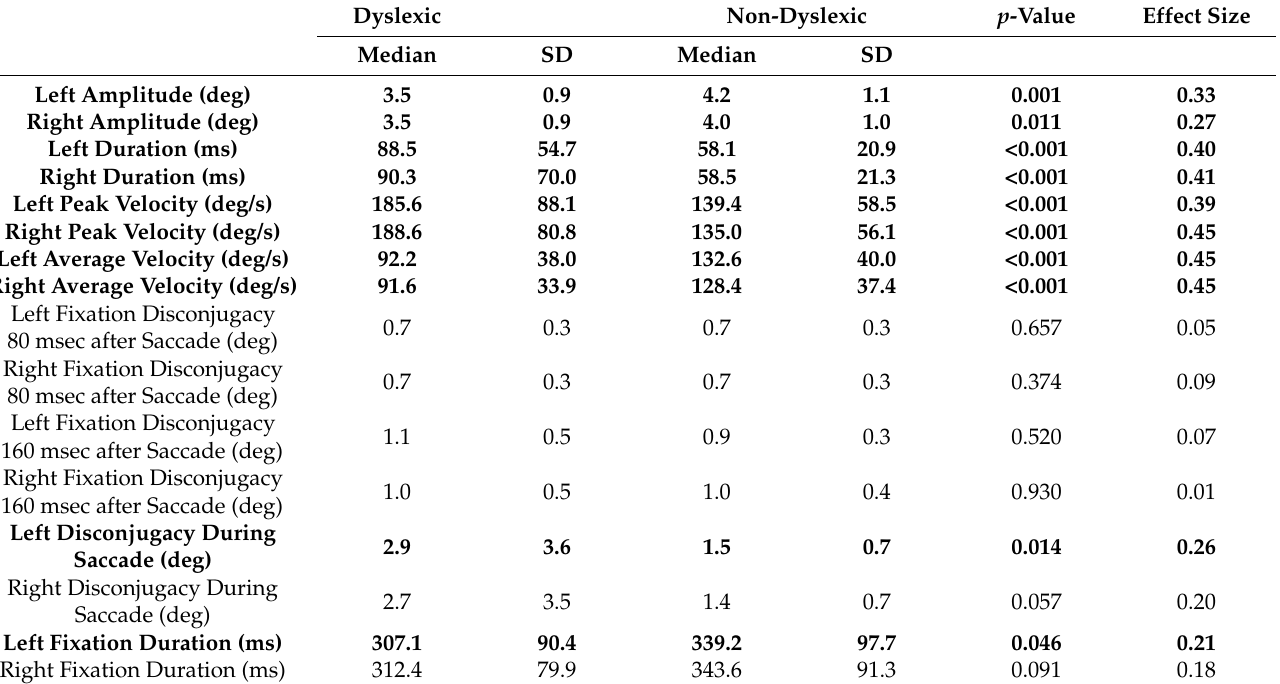
Eye movements while viewing Painting 3. Bolded values represent statistically significant